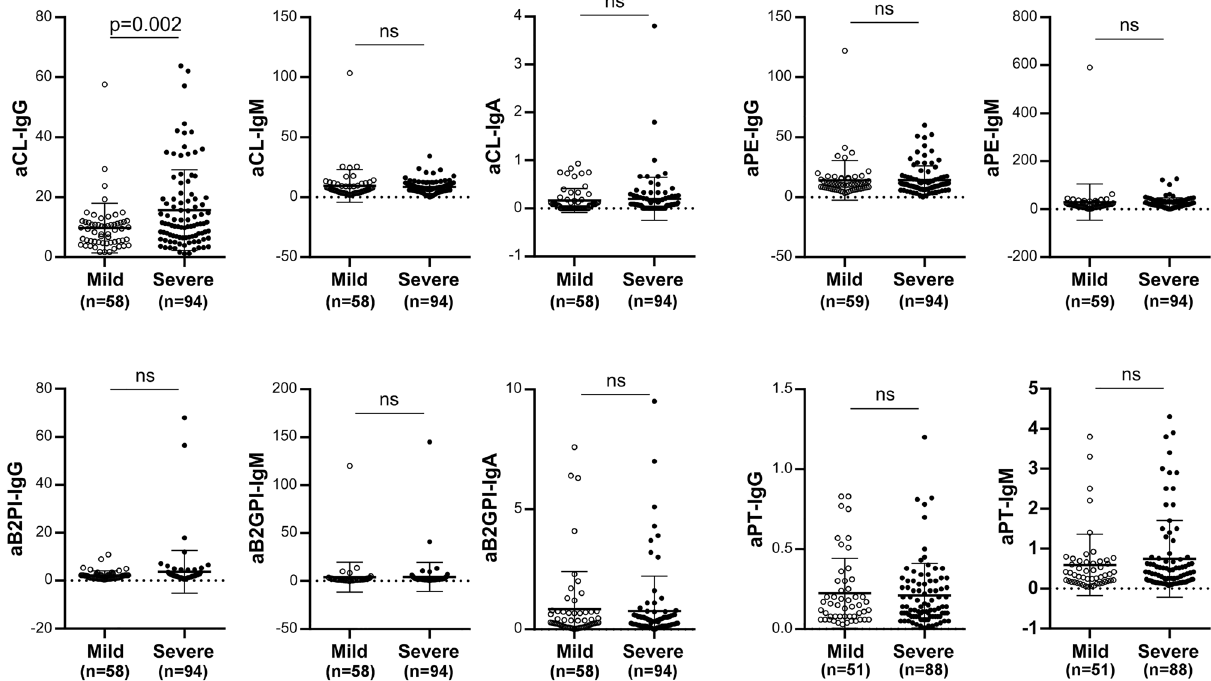
Figure 2. Antiphospholipid autoantibody levels in mild and severe patients with COVID-19. aCL anti-cardiolipin, aB2GPI anti-beta-2 glycoprotein I, aPE anti-phosphatidylethanolamine, aPT anti- prothrombin autoantibodies. Statistical analysis performed with Student’s t test. ns not